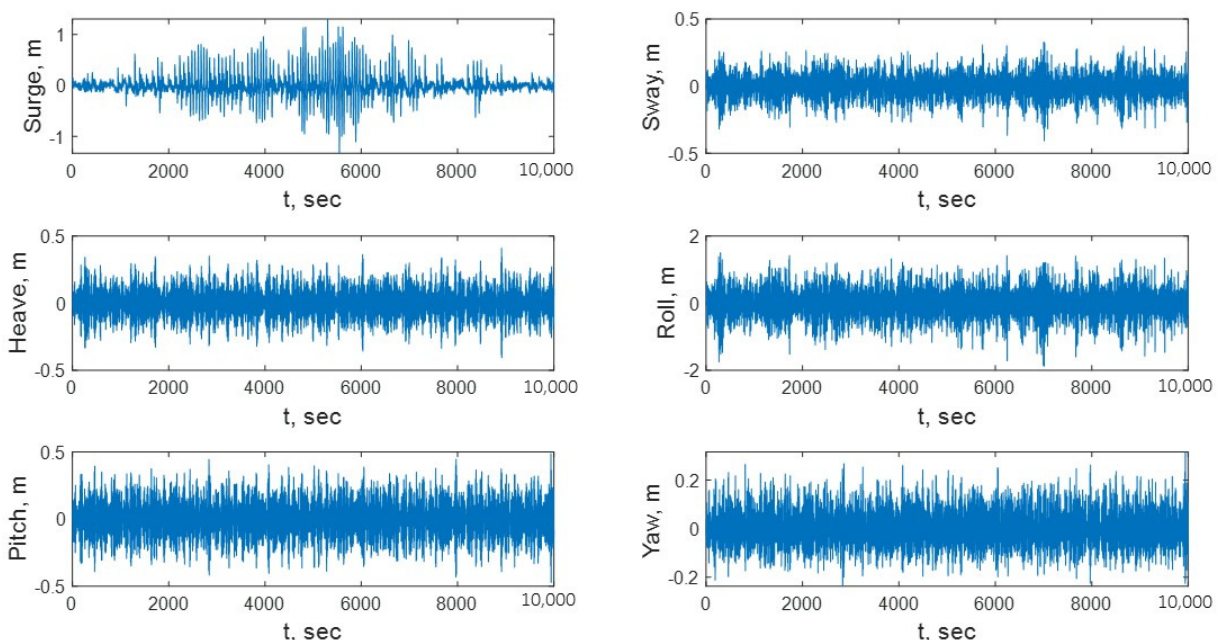
Figure A6. Load case s2 (H mo = 2.5 m)—wave frequency position. The surge and sway positions are relative to the position of the Delta, the other positions are absolute position of the ship.